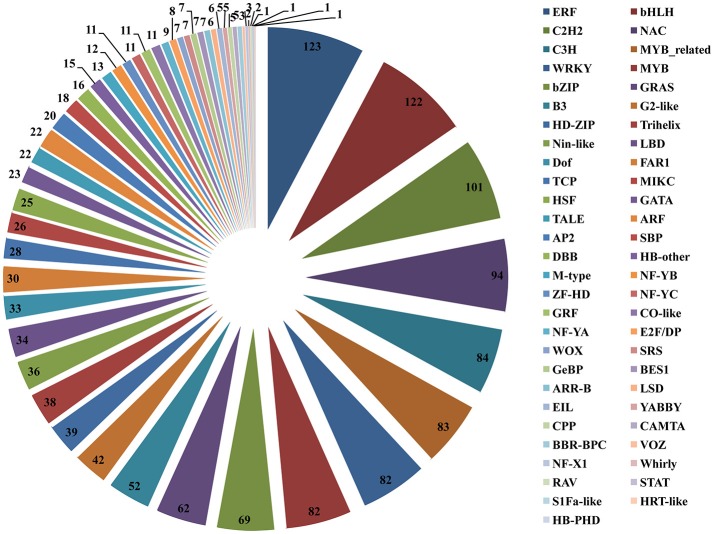
Distribution of transcription factor (TF) families. The right of the pie chart is the name of the all 55 annotated TF families. The number in the pie chart is the members of unigenes divided into each TF families.